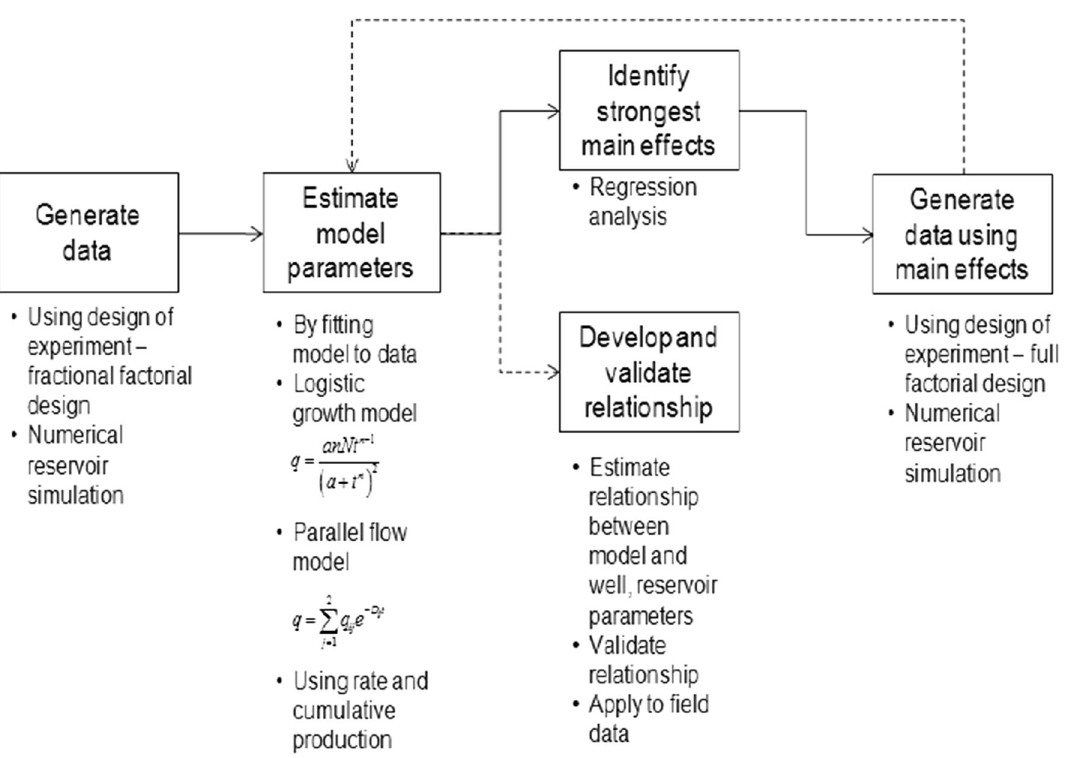
Fig. 7 Schematic diagram of the process used in developing the mathematical relationship between the model parameter and the reservoir and well completion properties